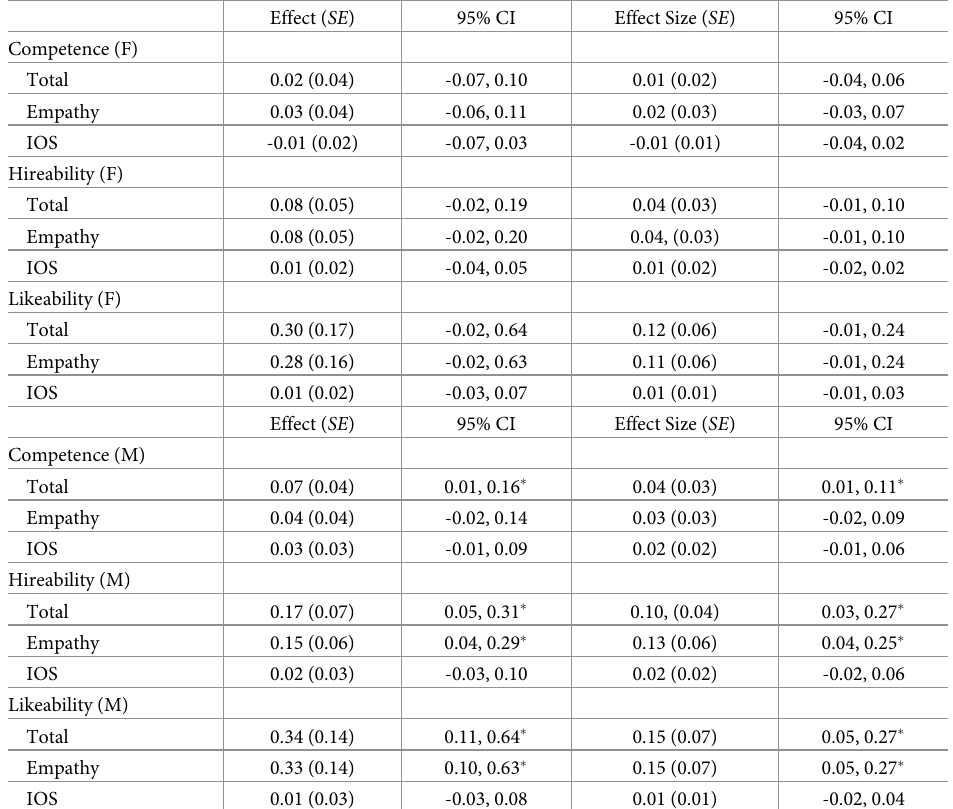
Table 13. Indirect effects of immersion on competence, hireability, and likeability.